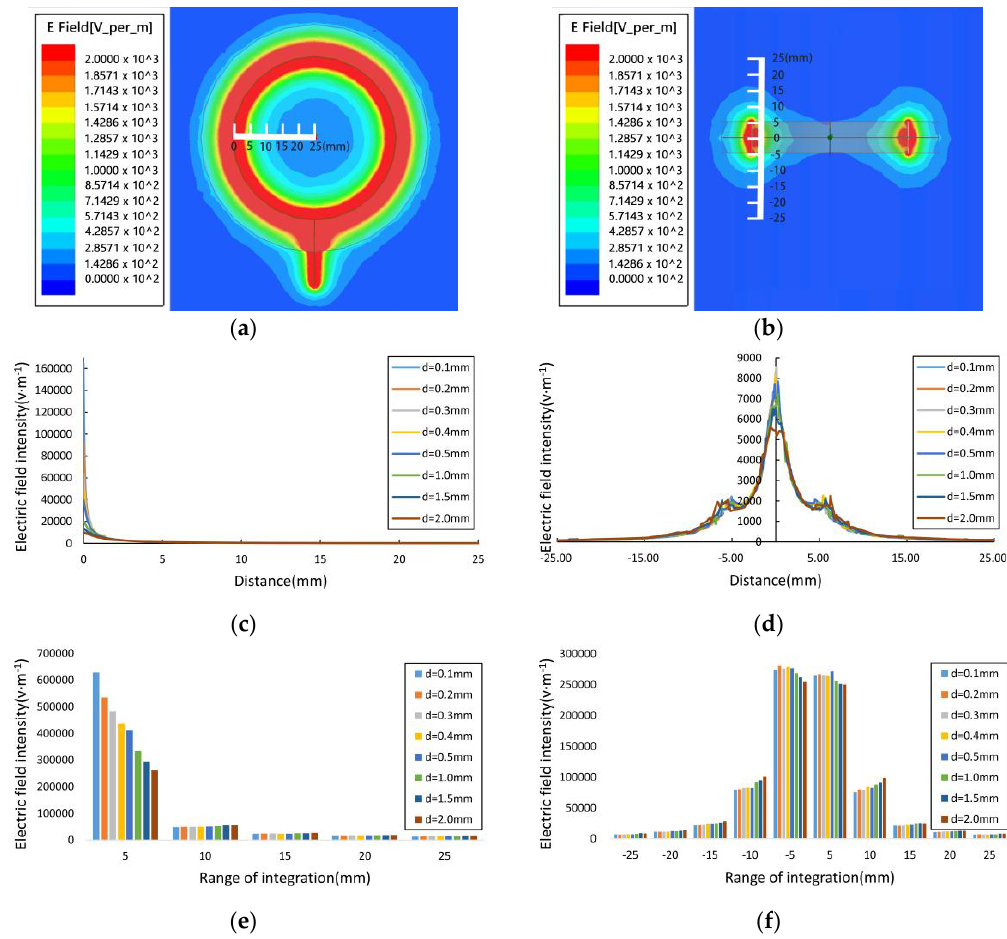
Figure 3. Simulation results for the measurement electrodes. ( a ) Horizontal electric field distribution of the electrode; ( b ) vertical electric field distribution of the electrode; ( c ) electric field intensity distribution curve in the horizontal diameter direction along the electrodes; ( d ) electric field intensity distribution curve in the electrode’s vertical direction; ( e ) electric field distribution histogram in the horizontal diameter direction along the electrode produced by the 5 mm piecewise integral accumulator; and ( f ) electric field distribution histogram in the vertical diameter direction along the electrode produced by the 5 mm piecewise integral accumulator.